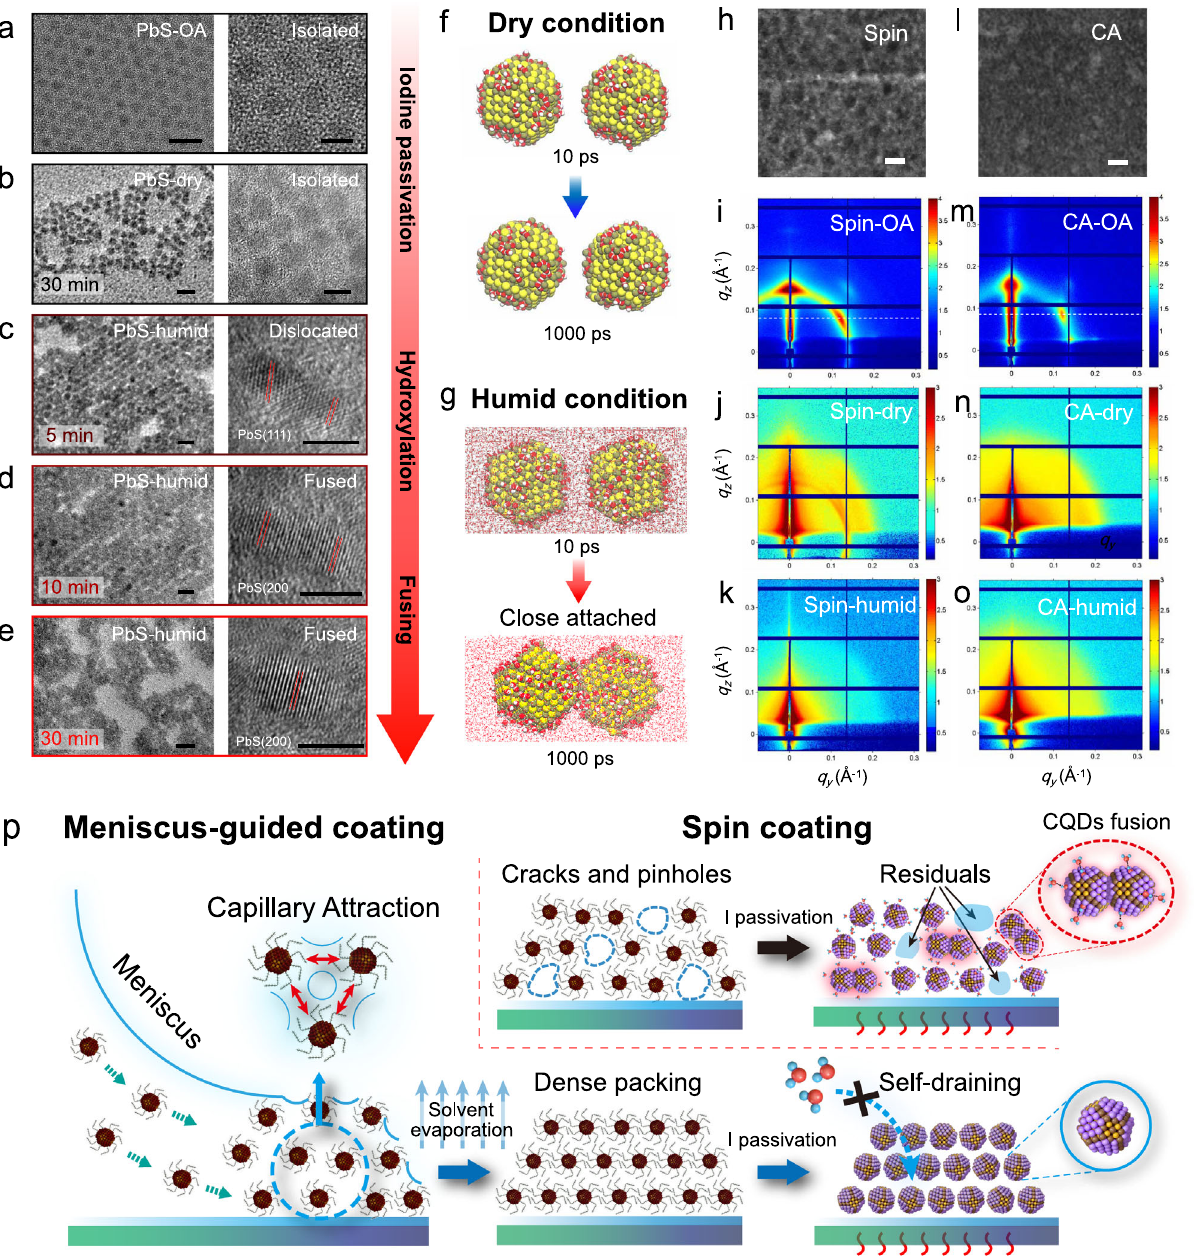
Fig. 2 The impact of ambient water on the CQD nanostructure and fi lm morphology. a – e The TEM images of PbS CQDs prepared under different conditions. The samples were prepared on carbon meshes by ( a ) droplet deposition ( b ) followed by ligand exchange and annealing process at 85 °C under dry air, ( c – e ) or under humid air with different annealing times. The scale bars: left column 10 nm and right column 5 nm. f , g Molecular dynamic simulation of the water effect on hydroxylated CQDs. Atom color: brown, Pb; yellow, S; red, O; white, H. Snapshots of two CQDs with surface hydroxyls covered